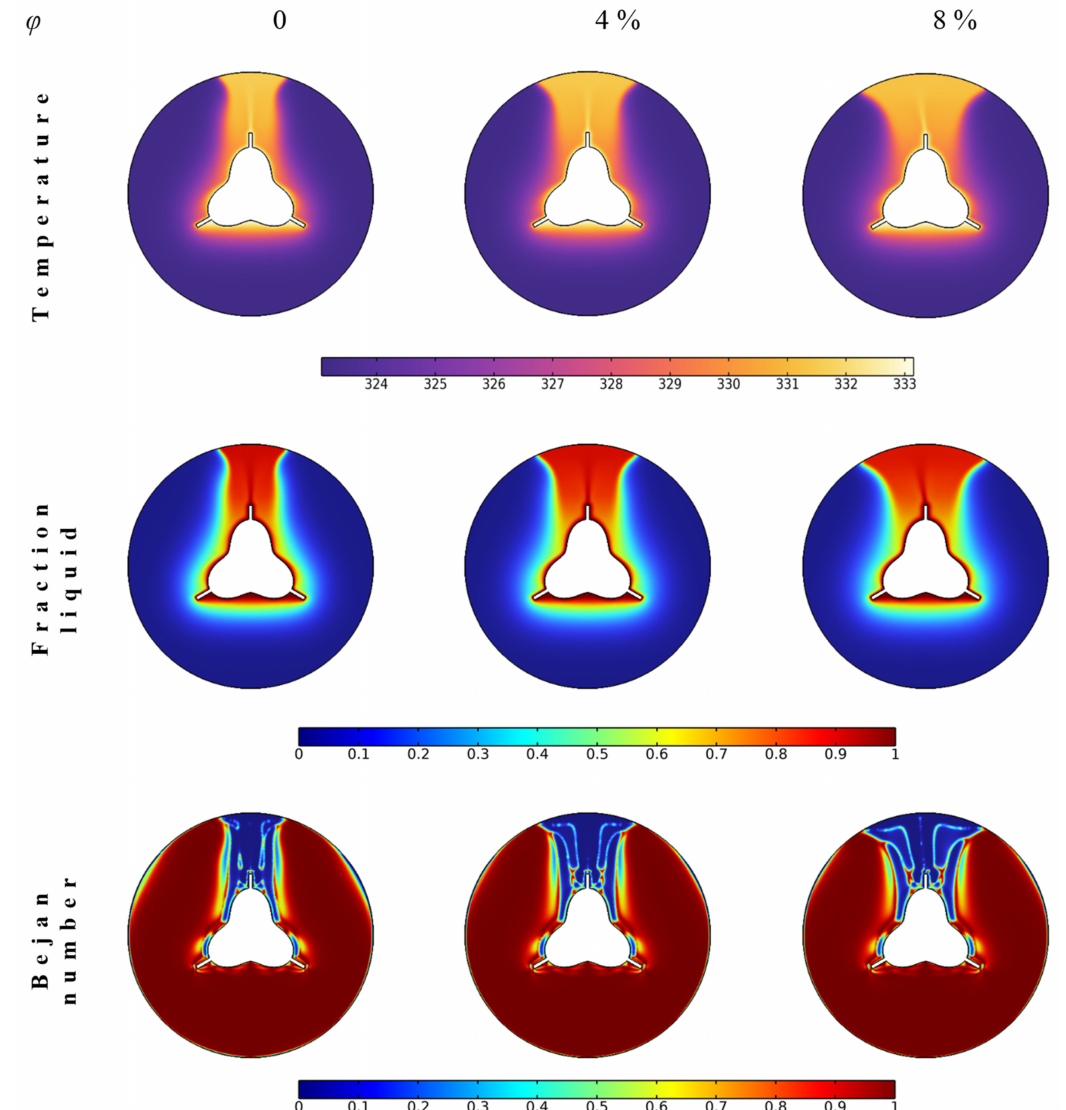
Figure 4. The contours of temperature, liquid fraction, and Bejan number for different cases of nanoparticle concentrations after 20